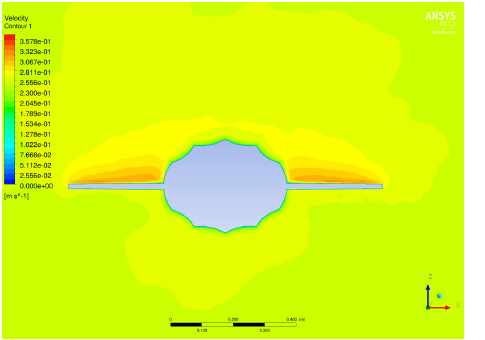
Figure 8. Velocity contour of the glider’s cross-section. Simulations performed using ANSYS Fluent ® R17.1